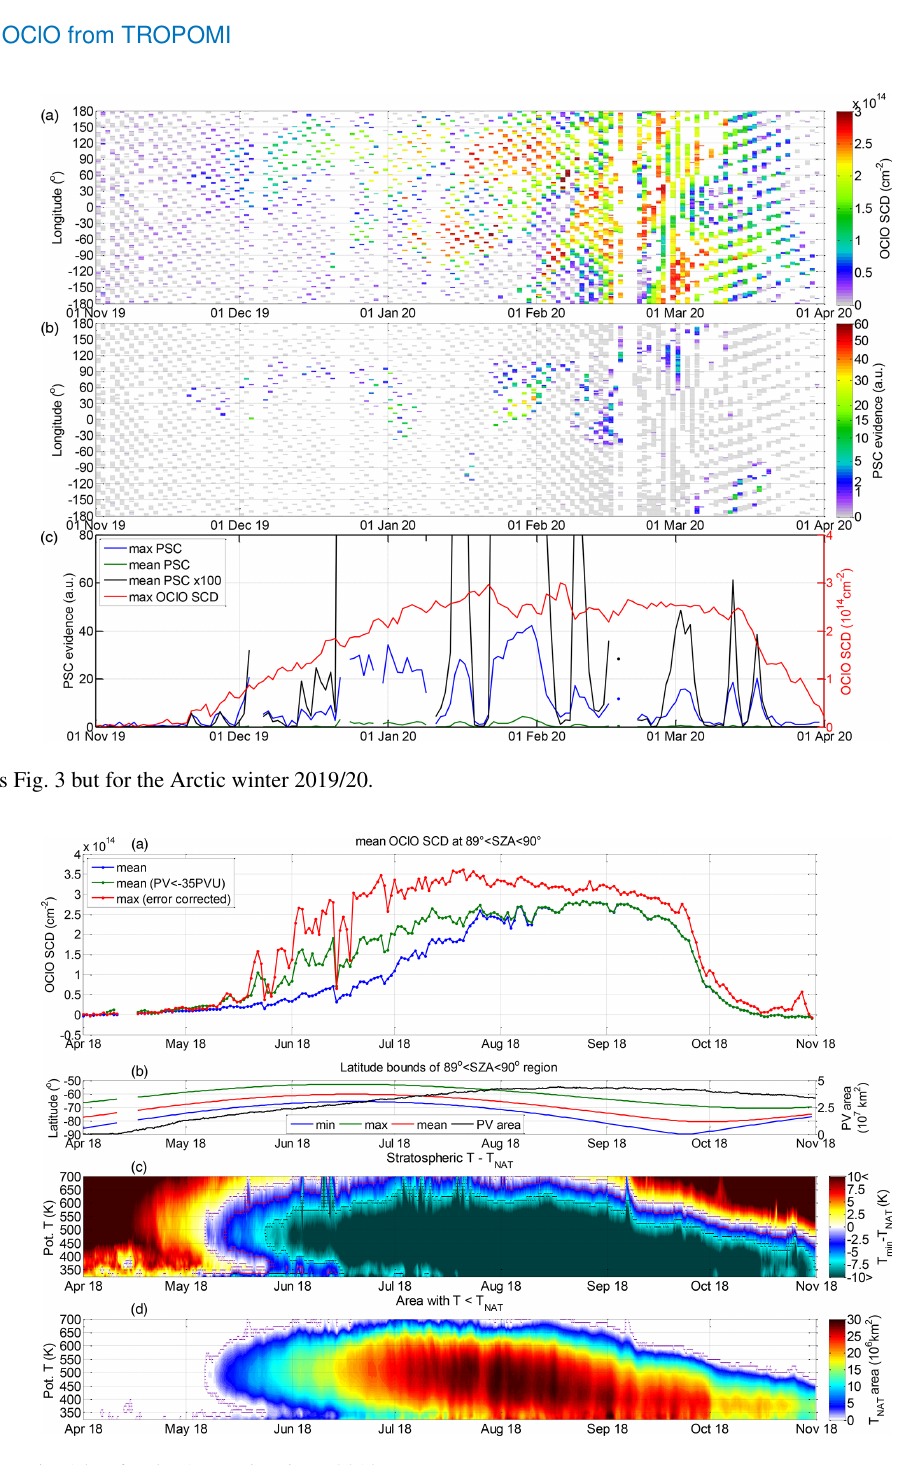
Figure 10. Same as Fig. 1 but for the Antarctic winter